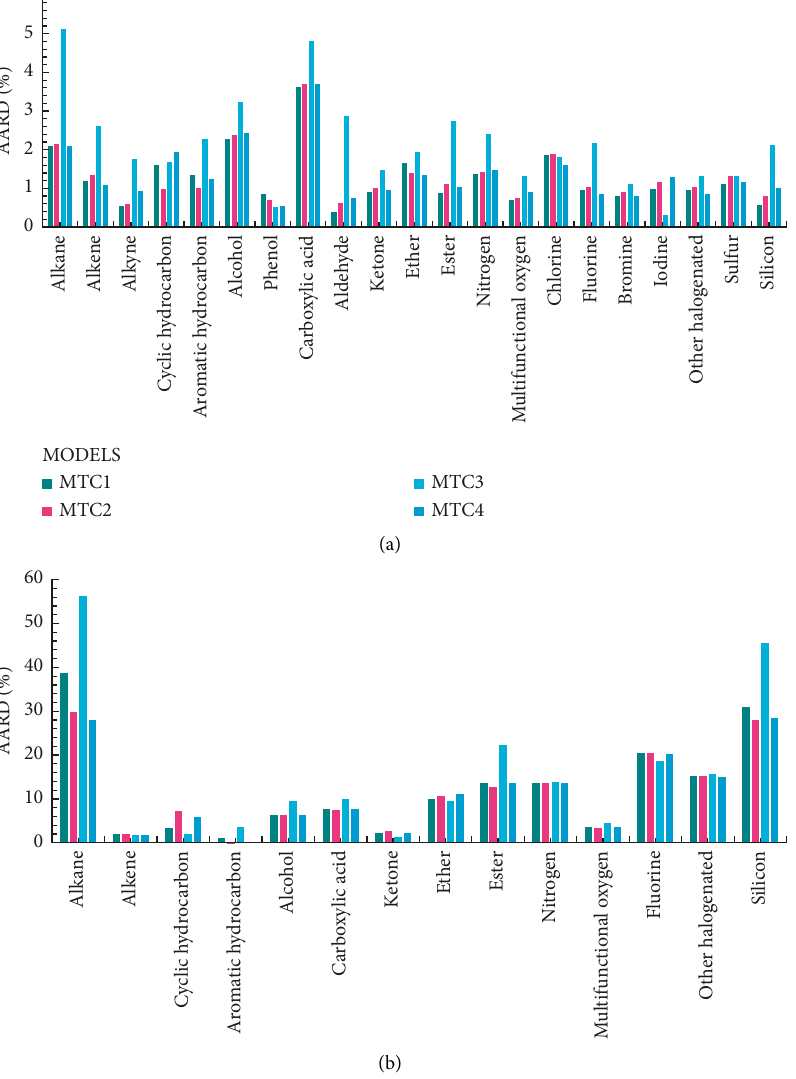
Figure 4: AARD for the calculation of the critical temperature of pure compounds using different first-order GCMs. (a) Correlation and (b)